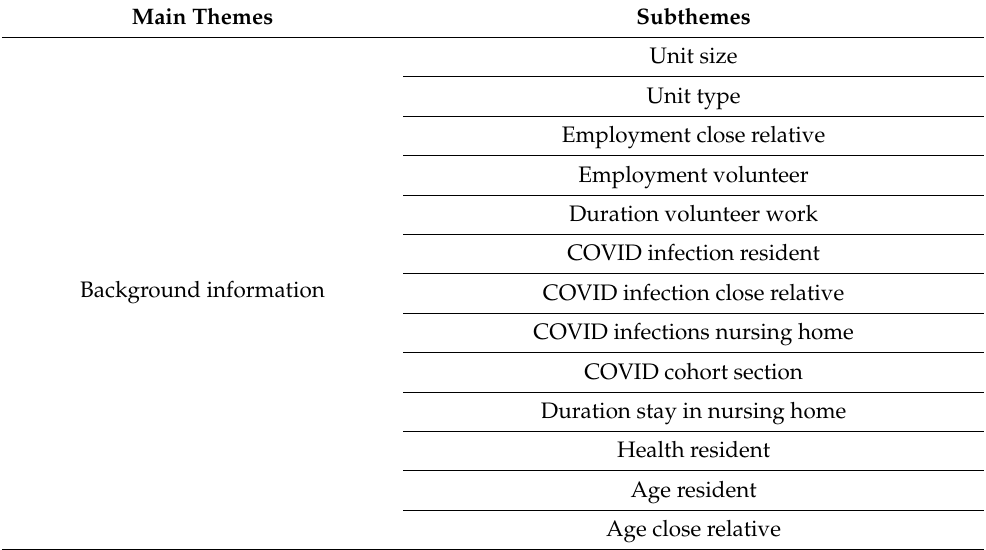
Table A3. Code tree of interviews and focus